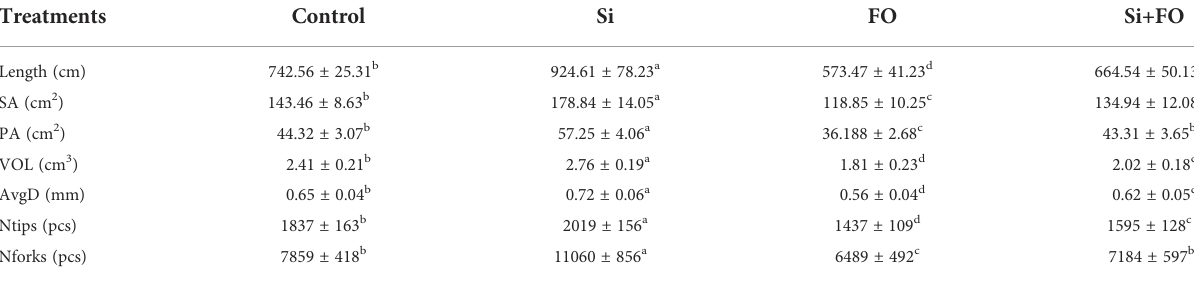
TABLE 2 Effects of exogenous silicon application on root traits of cucumber plants as in fl uenced by Fusarium wilt. Treatments